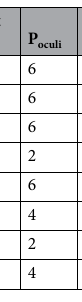
Table 4. Comparison between the shortest radiologically measured EFND per subject and the estimated position of the contact showing a clear peak in both EMG channels during